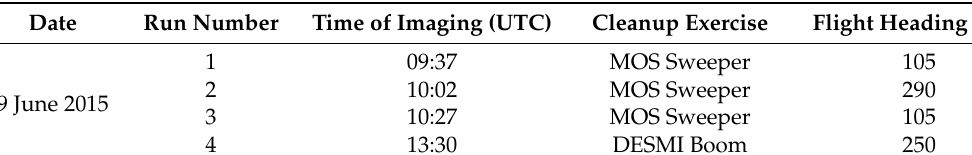
Table 3. Properties of the SETHI L-band POLSAR scenes investigated in this study.